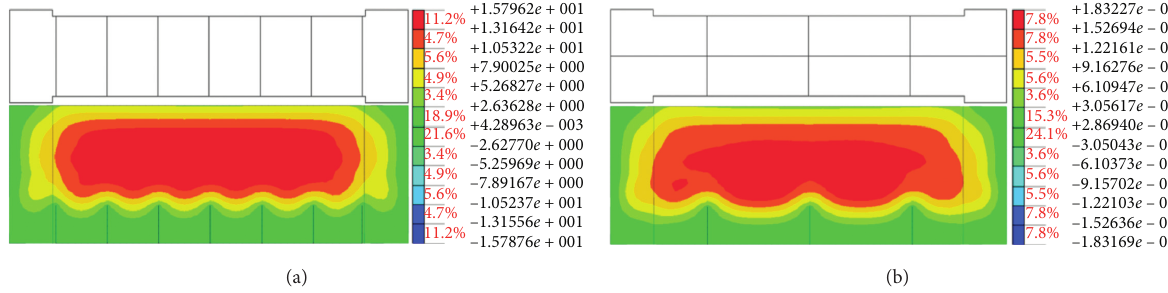
Figure 19: Wall deflection under two different layout forms of the cross wall. (a) Vertical cross wall bay. (b) Horizontal cross wall bay.